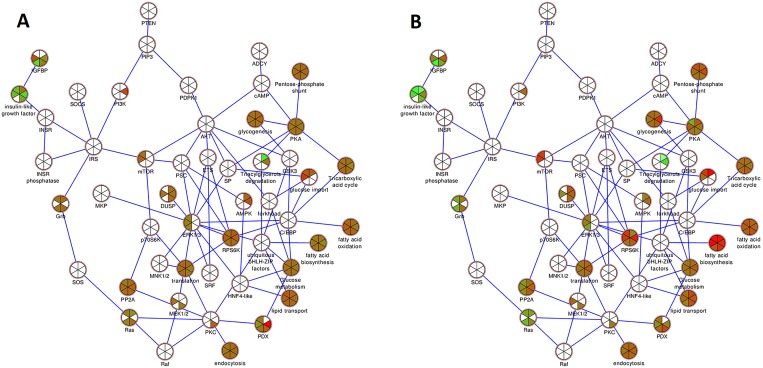
Insulin action, top scoring pathway for islet proteomics data.Down-regulated (green), up-regulated (red), unchanged (brown) and not detected (white) proteins when control (C) and P2 islets (A) and C and P7 islets (B) were compared. Each wedge in a node represents one of the six donors, the position of a particular donor’s wedge in a node is consistent throughout the figure.